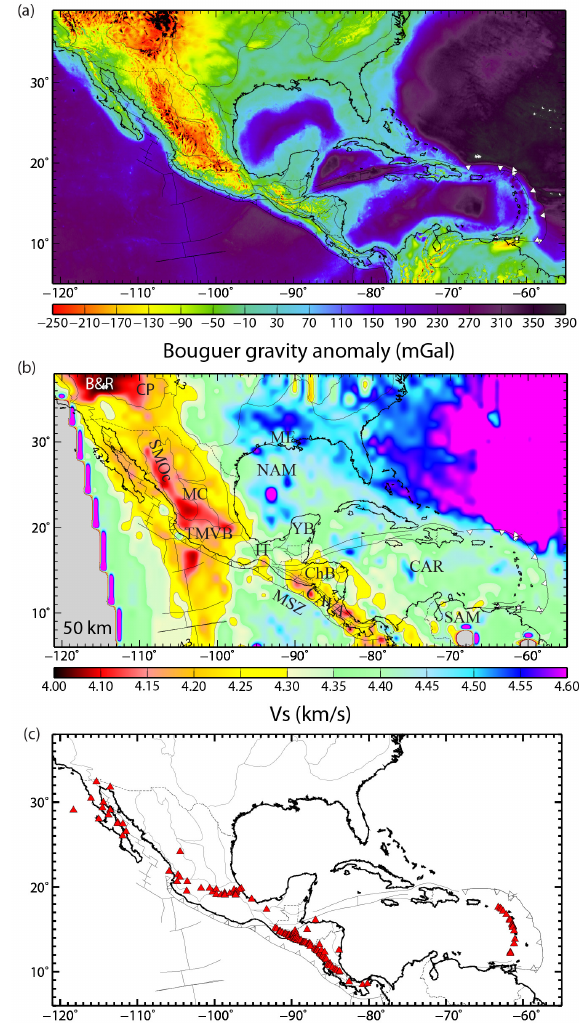
Figure 11. (a) Bouguer gravity anomaly map. (b) Shear wave veloc- ity map at 50km depth. (c) Map with the location of volcanoes (red triangles) exhibiting current unrest or eruptions during the Holocene (Siebert and Simkin, 2002). B&R denotes Basin and Range; CAR Caribbean plate; CAVA Central America Volcanic Arc; ChB Chortis Block; CP Colorado Plateau; IT Isthmus of Tehuantepec; ME Mis- sissippi Embayment; MSZ Mesoamerican Subduction Zone; NAM North American plate; SAM South American plate; SMOc Sierra Madre Occidental; TMVB Trans-Mexican Volcanic Belt; and YB Yucatan